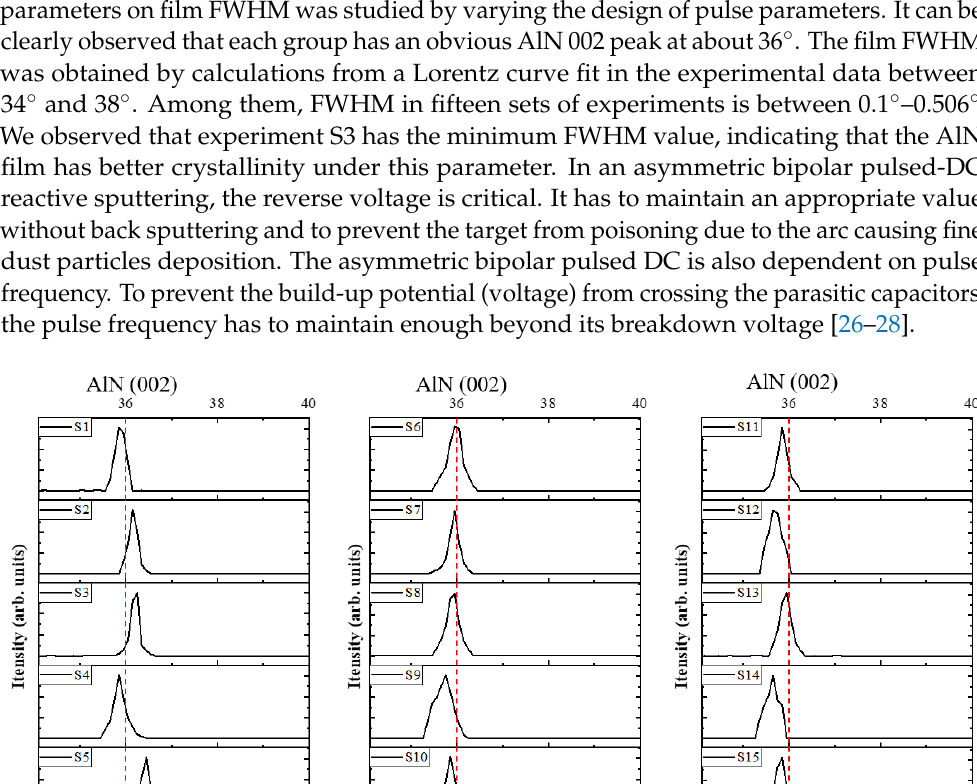
Table 3. Results of characterization for 15 experimental sets.